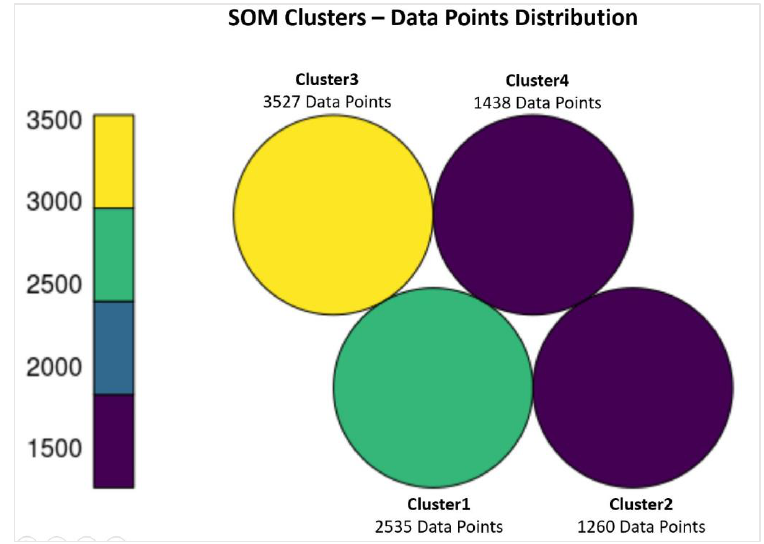
Figure 9. Data point distribution in SOM clusters.